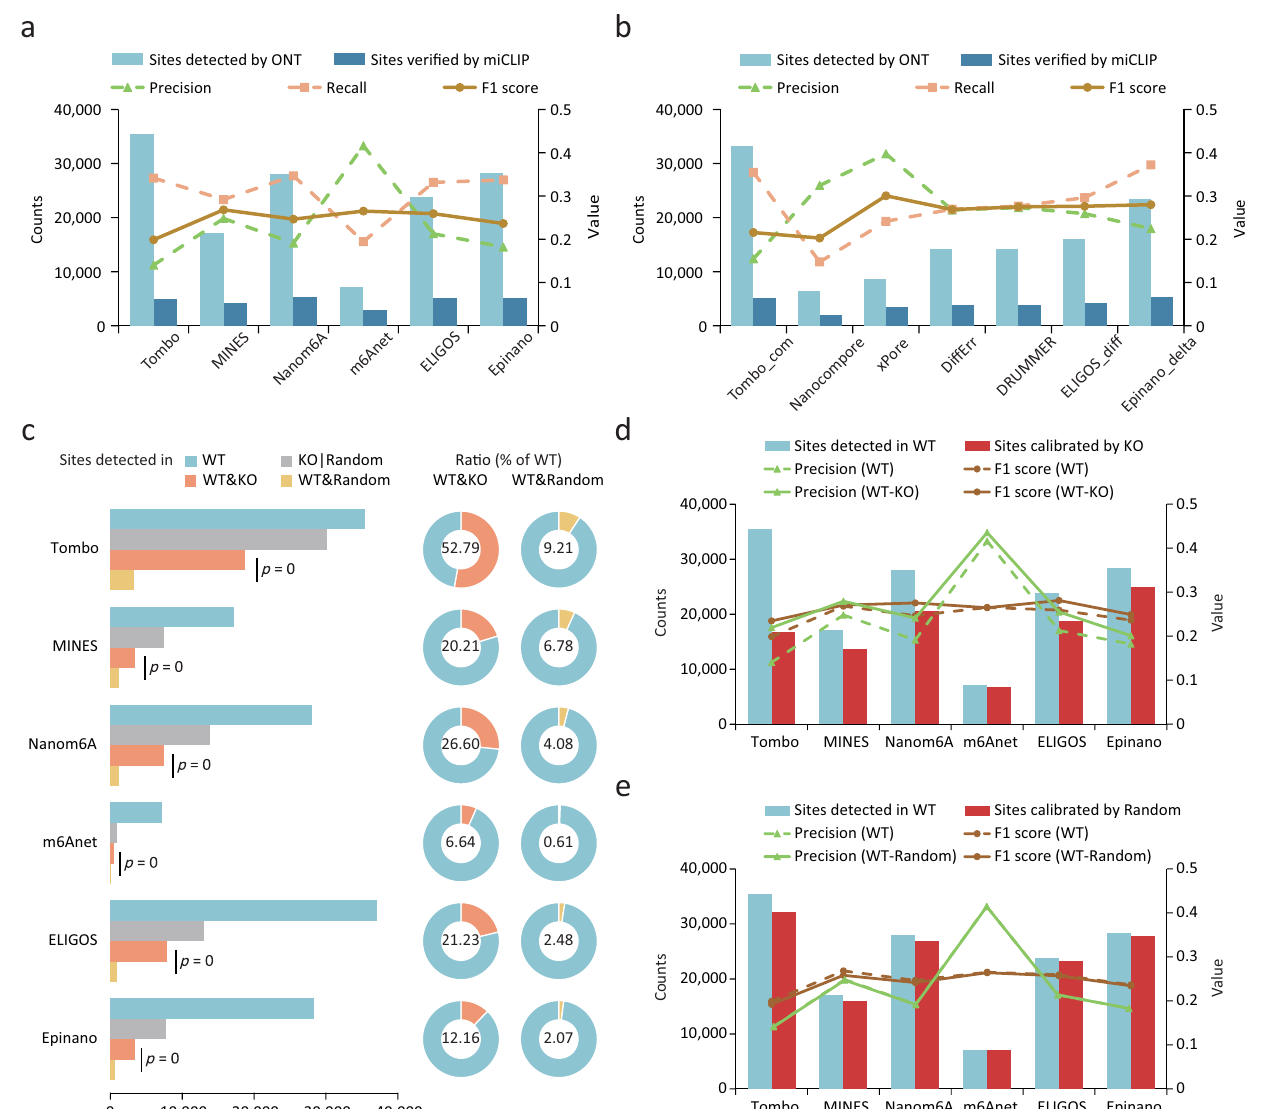
Fig. 3 | Assessment of intrinsic bias and the effects of using a negative control onm6Adetection.a , b Precision,recallandF1scoresforsingle-modetools( a )and compare-mode tools ( b ) using miCLIP results as validation set. c Counts and per- centages of recurrent m6A sites identi fi ed amongst samples. One-sided Hyper- geometrictestswereappliedtocalculatesigni fi cance.WT&KO,bothinWTandKO; WT&Random, both in WT and Random; KO|Random, the total number in KO or